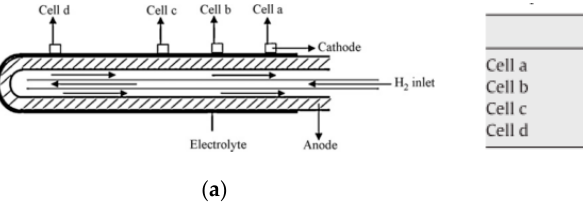
Figure 17. ( a ) Current collector configurations and ( b ) cell specifications [143].